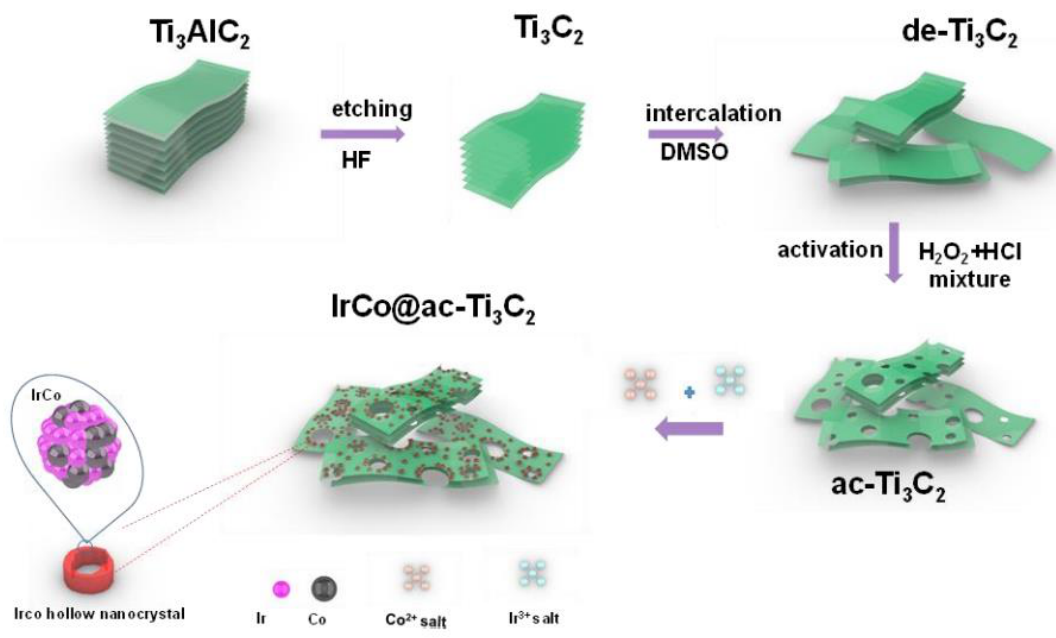
Figure 11. Scheme of the synthesis of IrCo supported on porous ac-Ti 3 C 2 . Adapted with permis- sion from [182], Copyright 2020, John Wiley and Sons. from [182], Copyright 2020, John Wiley and